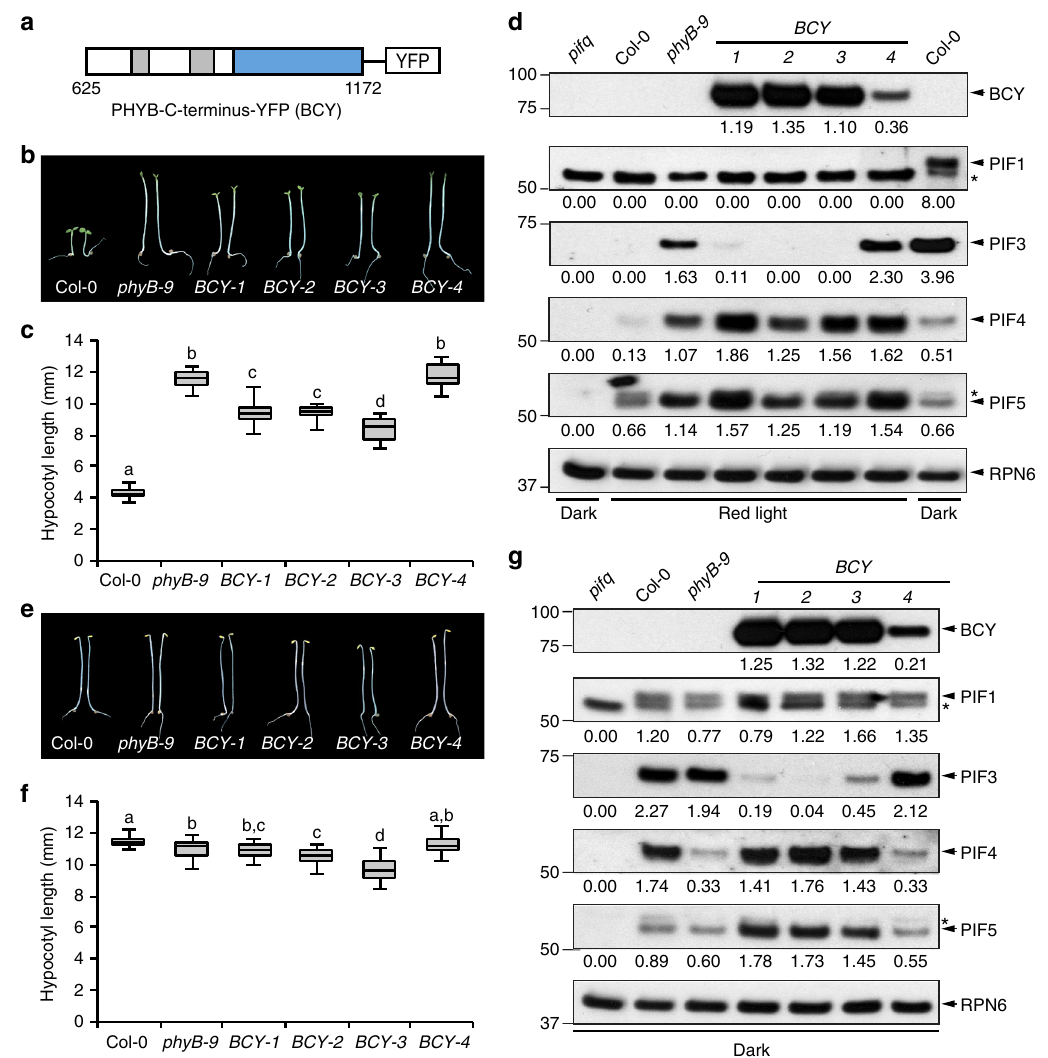
Fig. 2 The C-terminal module of PHYB is biologically active to regulate hypocotyl growth and mediate PIF3 degradation. a Schematic illustration of the domain structures of PHYB-C-terminus-YFP (BCY). b Images of 4-day-old Col-0, phyB-9 , and BCY-1 to BCY-4 transgenic lines grown in 10 μ mol m − 2 s − 1 R light. c Hypocotyl measurements of Col-0, phyB-9 , and BCY transgenic lines grown in 10 μ mol m − 2 s − 1 R light. The boxes represent from 25th to 75th percentile; the bars equal to the median values. Samples with different letters exhibit statistically signi fi cant differences in hypocotyl length (ANOVA, Tukey ’ s HSD, P < 0.01, n > 40). d Immunoblots showing the steady-state levels of BCY, PIF1, PIF3, PIF4, and PIF5 in the indicated lines grown in 10 μ mol m − 2 s − 1 R light. Dark-grown Col-0 and pifq samples were used as positive and negative controls for PIFs, and RPN6 was used as a loading control. The relative protein levels were normalized to the corresponding levels of RPN6 and are shown below each lanes. e Images of 4-day-old Col-0, phyB-9 , and BCY-1 to BCY-4 transgenic lines grown in the dark. f Hypocotyl measurements of Col-0, phyB-9 , and BCY transgenic lines grown in the dark. The boxes represent from 25th to 75th percentile; the bars equal to the median values. Samples with different letters exhibit statistically signi fi cant differences in hypocotyl length (ANOVA, Tukey ’ s HSD, P < 0.01, n > 40). g Immunoblots showing the steady-state levels of BCY, PIF1, PIF3, PIF4, and PIF5 in the indicated lines grown in the dark. Dark-grown Col-0 and pifq samples were used as positive and negative controls, respectively, for PIFs. RPN6 was used as a loading control. The relative protein levels were normalized to the corresponding levels of RPN6 and are shown below each